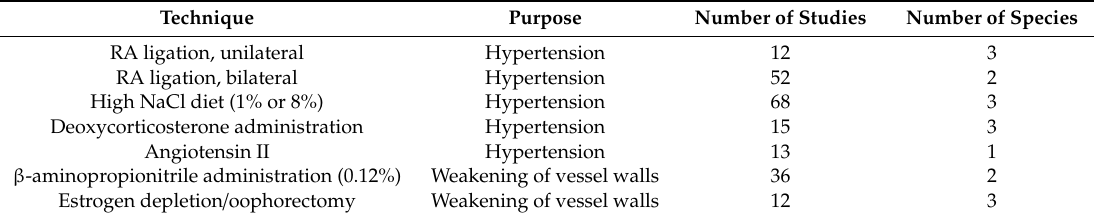
Table 4. Variations to established IA models pertaining to the technique to induce hypertension and weaken vessel walls.